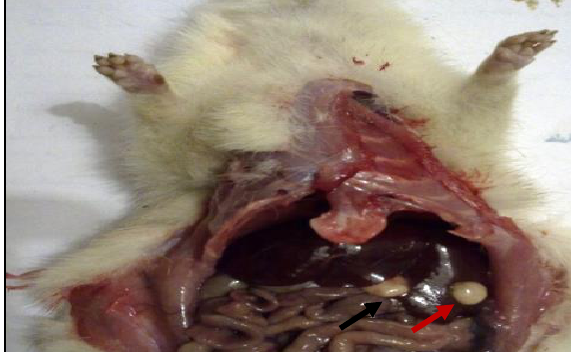
Figure, 1: The gross lesion liver of rat shows two visible Cysticercus granuloma cystic structures, raised above the parietal ( ) and visceral ( ) surfaces of the liver.